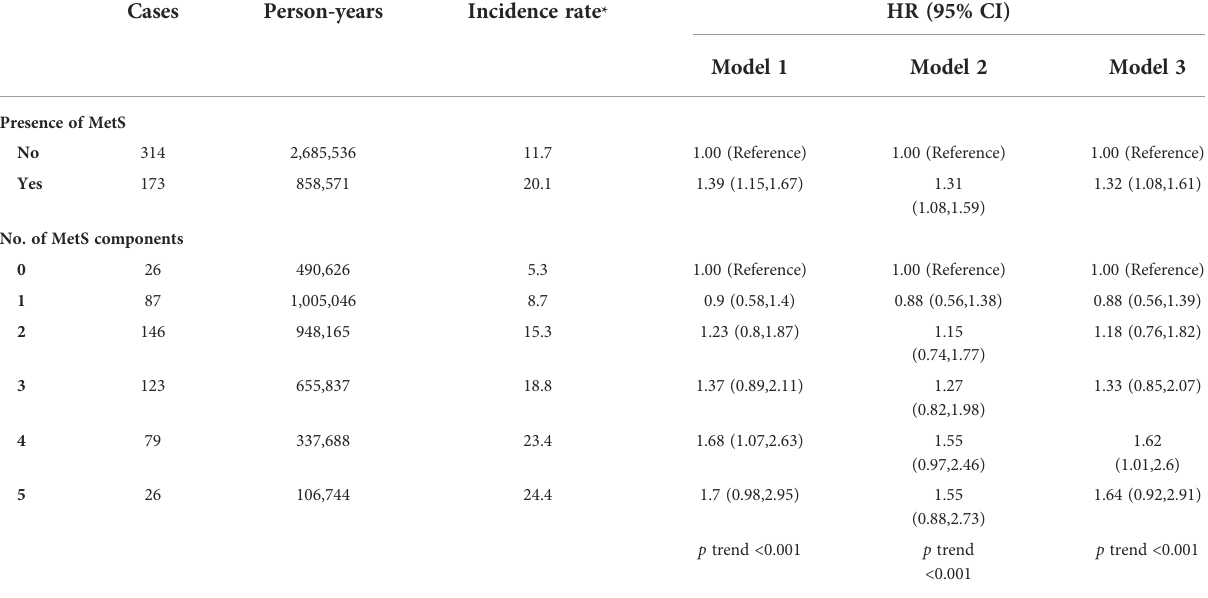
TABLE 2 Risk of bladder cancer according to metabolic